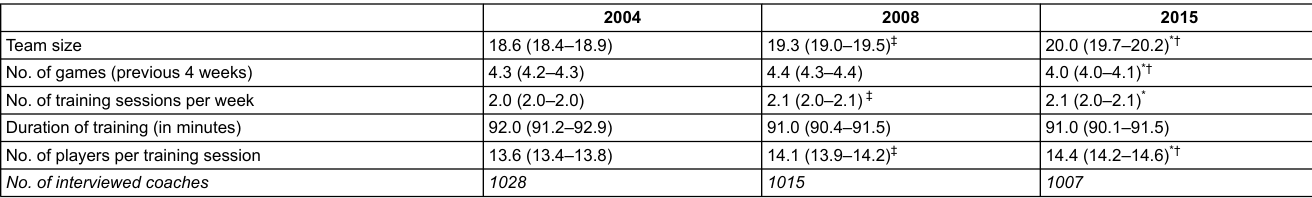
Table 1: Team and exposure characteristics (arithmetic mean and bias-corrected and accelerated 95% confidence